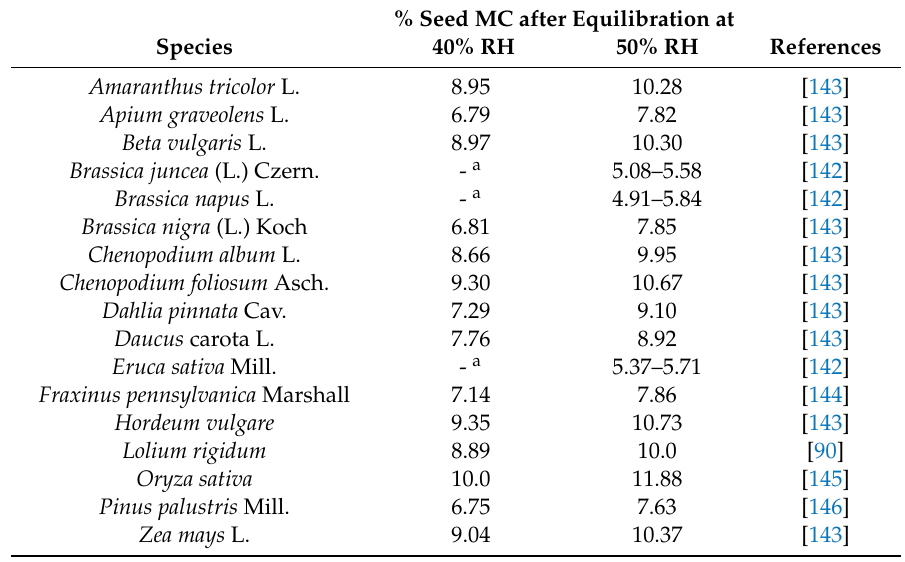
Table 3. Some examples of final % seed MC after seeds were allowed to equilibrate with 40% and 50% RH. Authorities are given only for species not mentioned in the